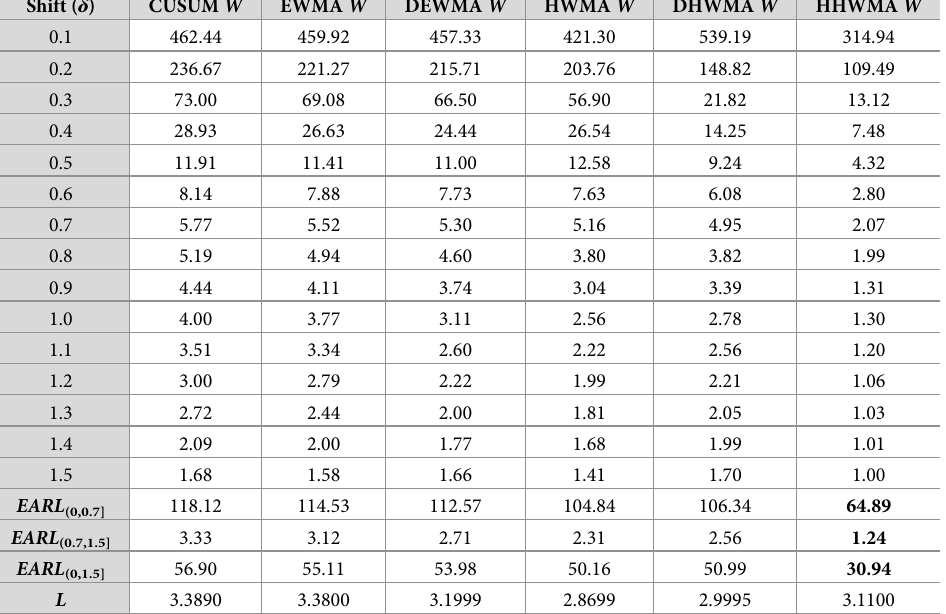
Table 7. The OOC ARL profiles of the proposed HWMA, DHWMA and HHWMA W schemes against the CUSUM, EWMA and DEWMA W schemes when ( m , n , λ )= (100,5,0.5) for a nominal ARL 0 = 500 under GAM (3,1)